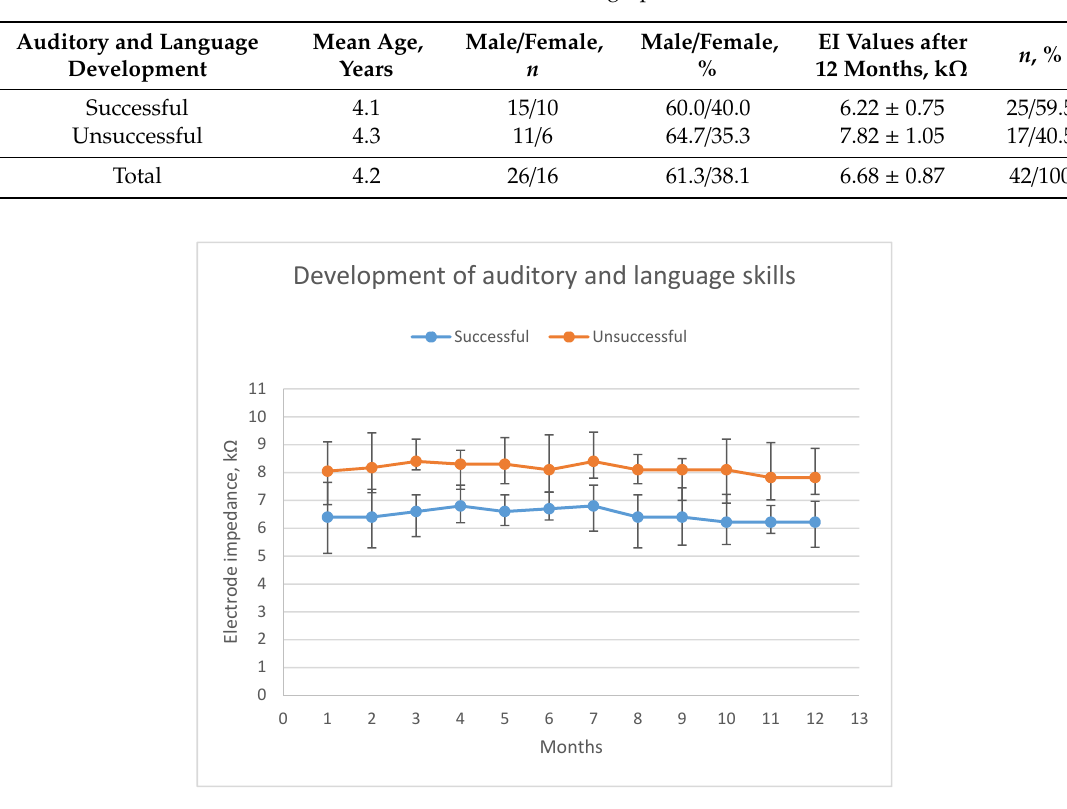
Figure 2. Evolution of EI values in the first 12 postoperative months compared between patients with Figure 1. Evolution of EI values in the first 12 postoperative months compared between patients with successful and patients with unsuccessful auditory and language skills development. X axis: time successful and patients with unsuccessful auditory and language skills development. X axis: time after cochlear implantation in months. Y axis: Values of electrode impedance in k Ω . Blue line: patients with successful development. Red line: patients with unsuccessful